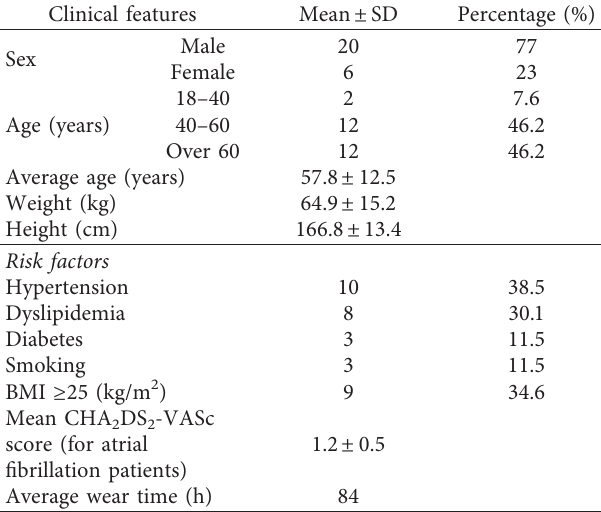
Table 1: General characteristics of the study participants. Clinical